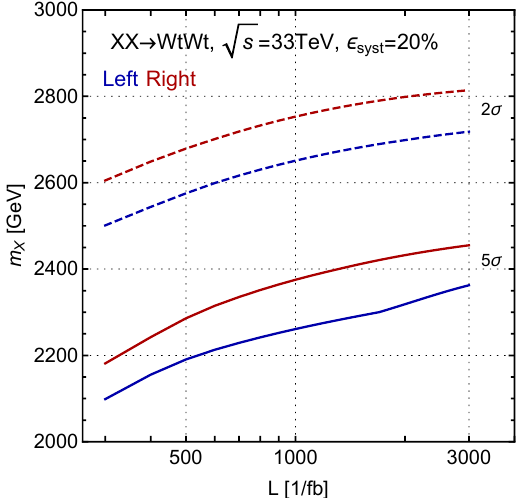
Figure 7 . Projected exclusion (dashed) and discovery (solid) reach of the same-sign dilepton search for a X VLQ decaying with 100% branching ratio into Wt for blue and red lines correspond to a left- and right-handed chiral coupling of the X VLQ. We assume an uncertainty on the background determination (cid:15) syst =